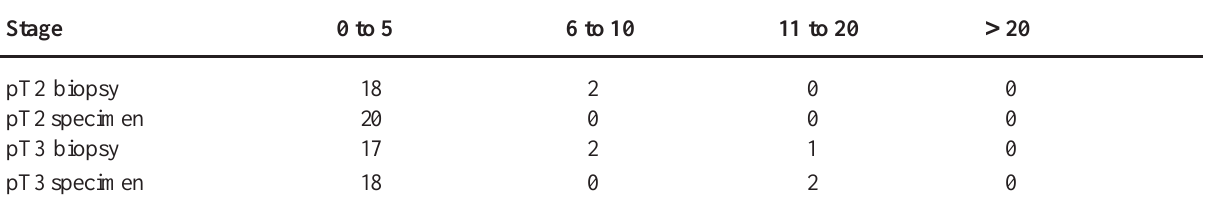
Table 5 – Number of patients that present Ki-67 nuclear expression in the biopsy and in the surgical specimen, in stages (pT2 and pT3). The columns refer to the percentage of cells with